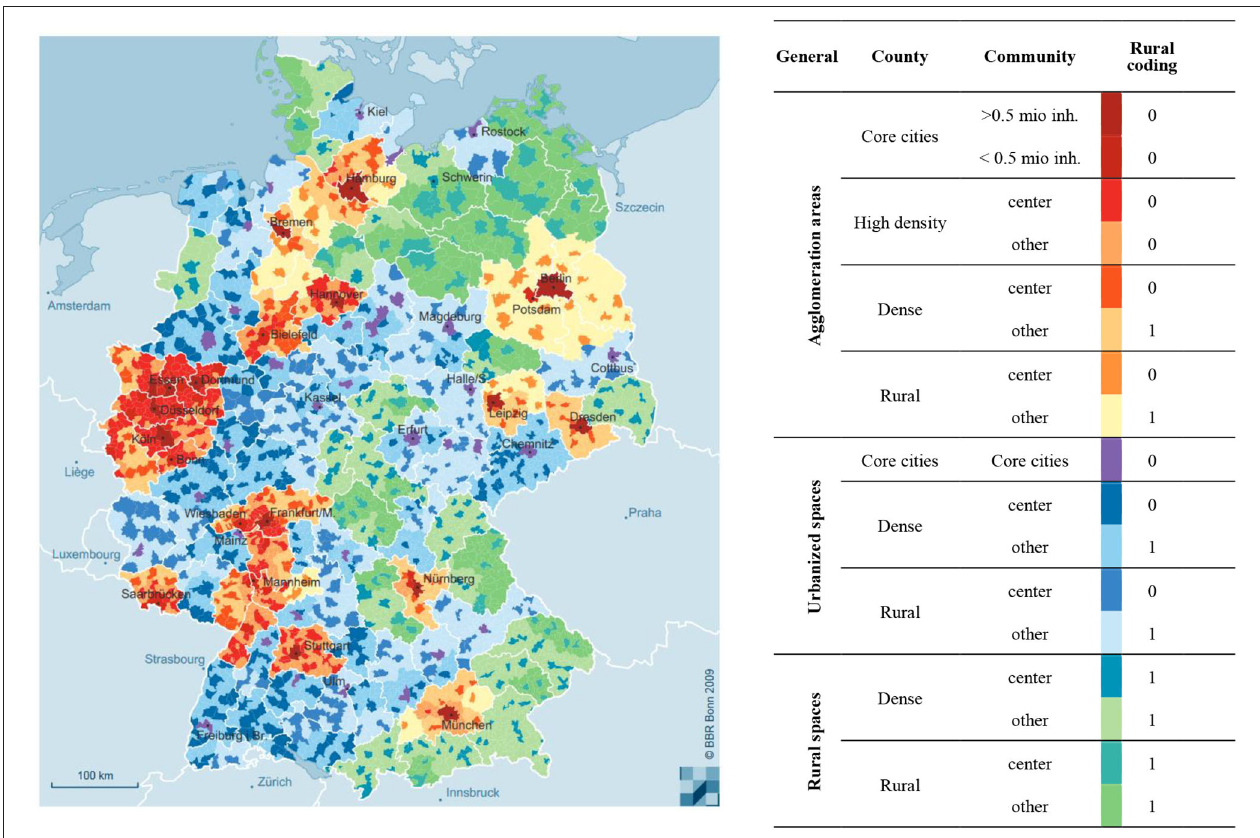
FIGURE 2 | Regional classifications available in SOEP data. Displayed are the 17 residential-structural community types in Germany, introduced by the Federal Institute for Research on Building, Urban Affairs and Spatial Development and available within scientific-use files for SOEP-surveys with regards to their place of residence. Figure adopted from BBR (2009), rural coding based on own